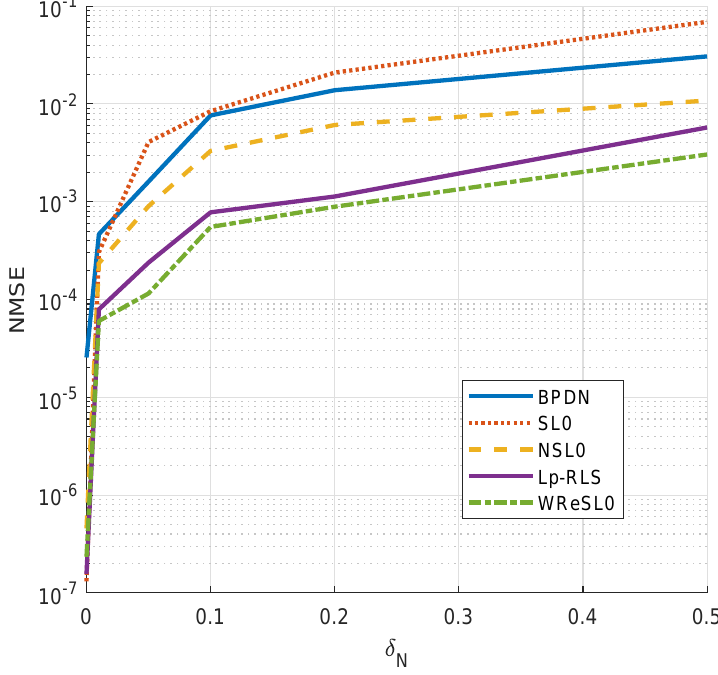
Figure 5. NMSE analysis by BPDN, SL0, NSL0, L p -RLS, and WReSL0 when noise intensity δ N changes according to the sequence [0, 0.1, 0.2, 0.3, 0.4,